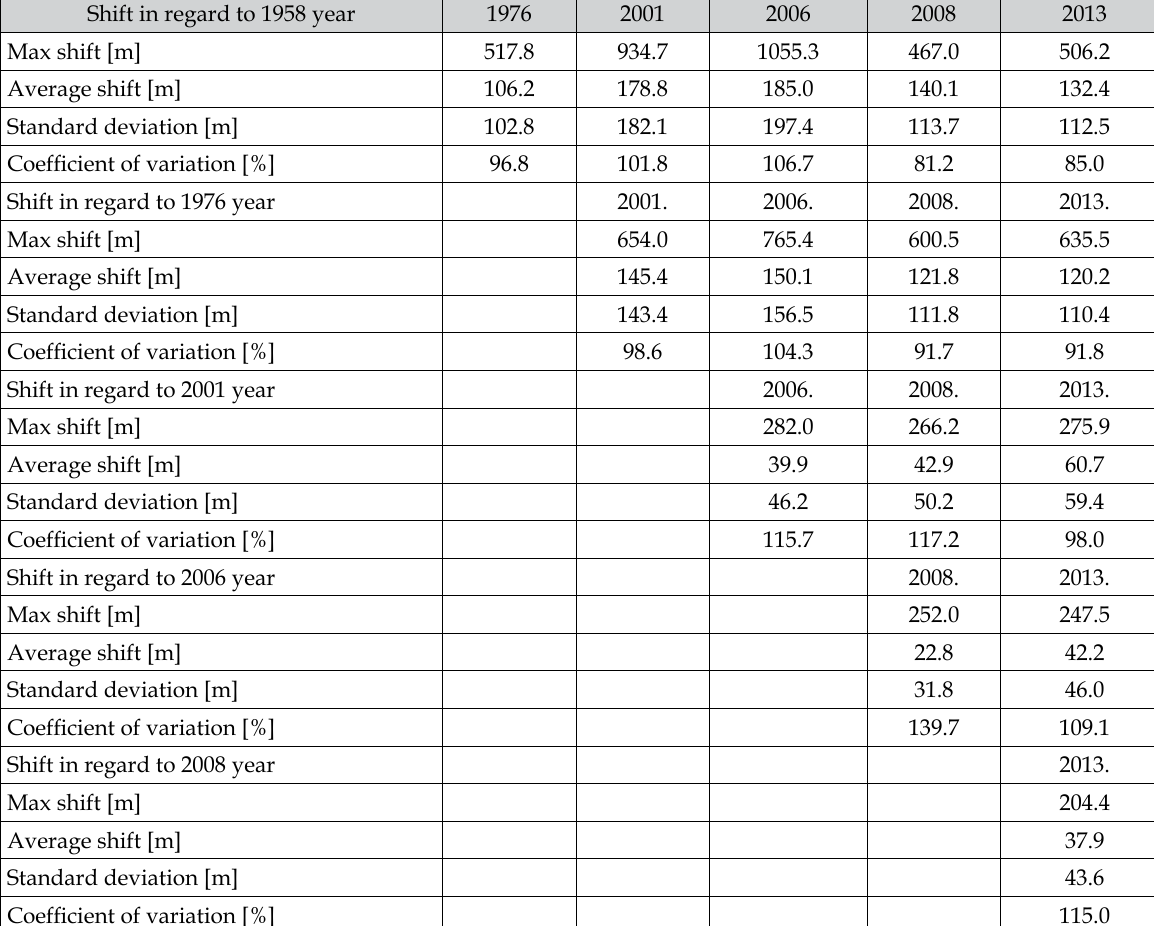
Table 4. Lateral shift of the centreline of Bosna River – total in meter (m).